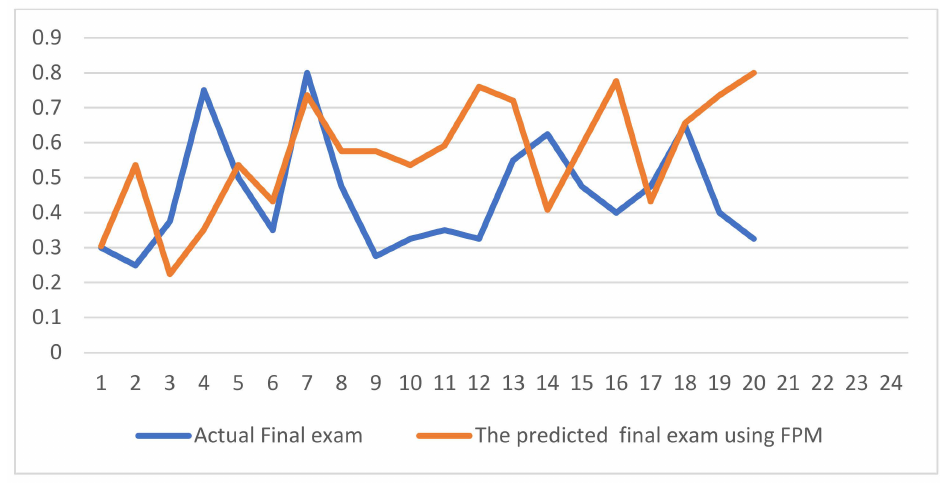
Figure 8. FPM result.